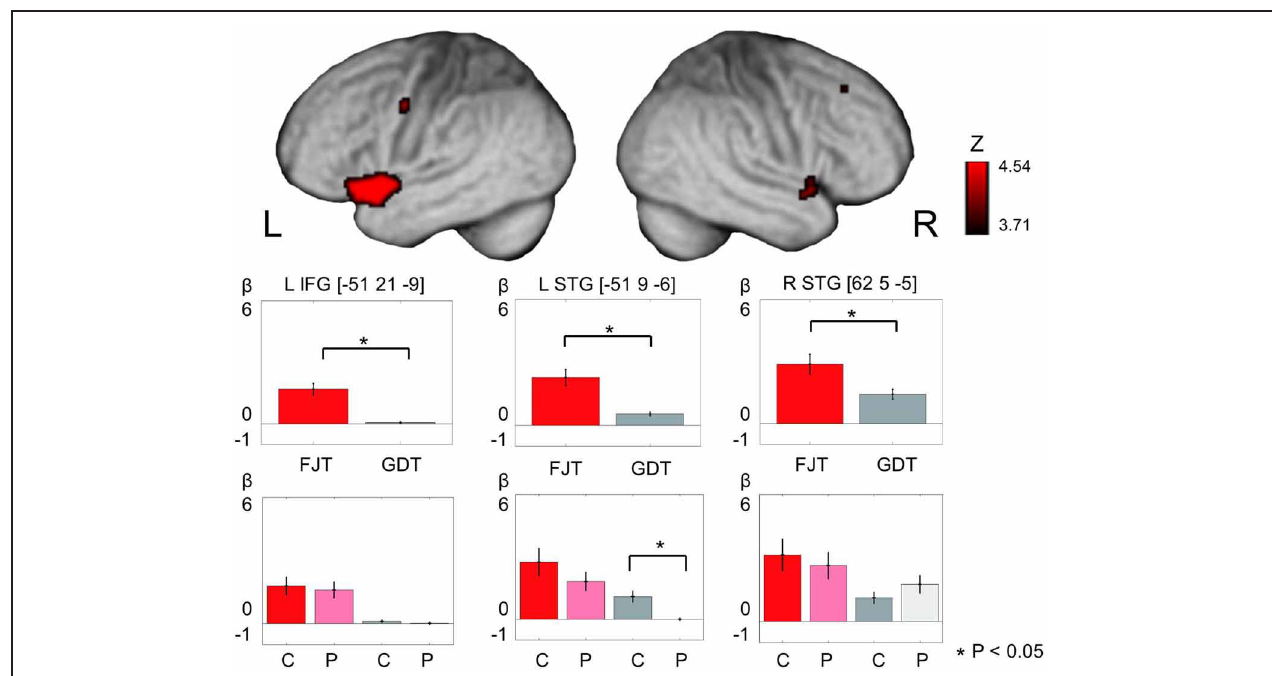
FIGURE 5 | The figure represents cerebral activation on main effect of task [(FJT/GDT): p < 0 . 05, voxel level, FDR-corrected]. Color bars show the distribution of beta values (mean ± SD ) under FJT (red) and GDT (gray). ∗ Indicates p < 0 . 05—L, left; R, right; dark color, controls; light color, patients.